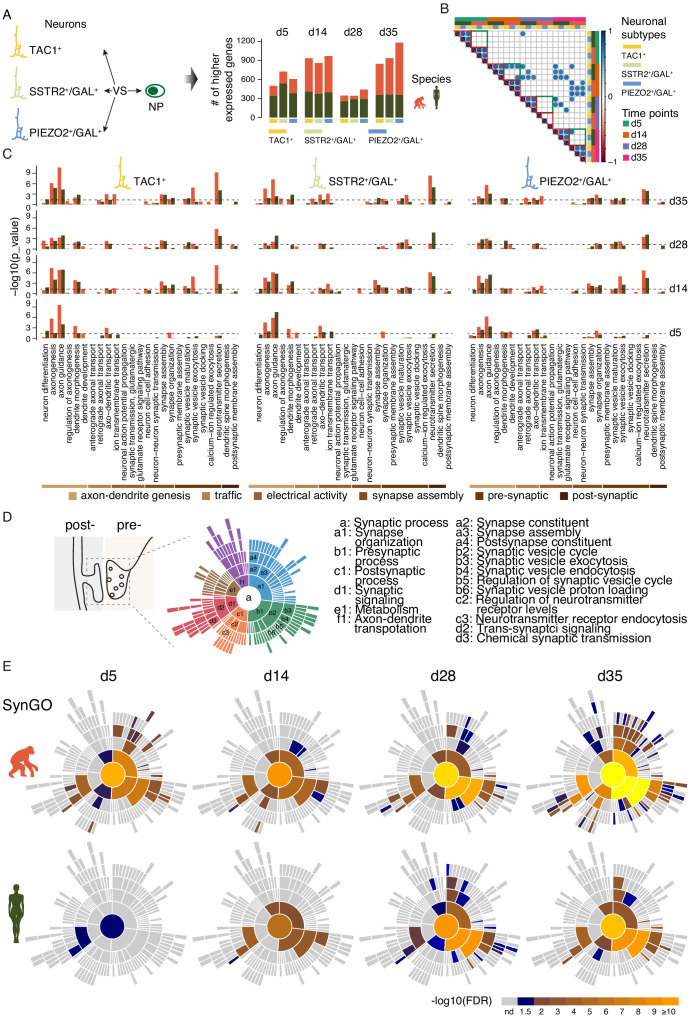
scRNAseq analysis of synaptic maturation in ape and human iNs.(A) Higher expressed genes in ape and human iN sub-classes compared with corresponding NP of the same species at multiple time points. Left panel, schematics of cell populations for the identification of differentially expressed genes; right panel, bar plot of numbers of higher expressed genes in ape and human iNs. (B) Pearson correlation of enriched GO terms in iNs sub types. Circles represent correlation coefficient larger than 0.7. Red triangles indicate correlations between sub types of same species. Green boxes indicate correlations within the same sub types but between different species. (C) Categories of GO terms on biological processes (BP) enriched with higher expressed genes in ape (orange) and human (green) iN sub-populations at each time point. Reference dashed line (blue) represents p-value of 0.05 (binomial test). (D) Left, schematic representation of synaptic parts depicted by SynGO ontology analysis. Right, six top levels (a1–f1) and selected sub-classifiers of SynGO BP terms. (a, synaptic process). (E) Sunburst plots of enriched synaptic GO terms in developing ape (top) and human (bottom) iNs. Bottom, the log10-transformed FDR-corrected p value per ontology term is visualized for BP. Note that the bottom BP sunburst plots are aligned with the top-right one.